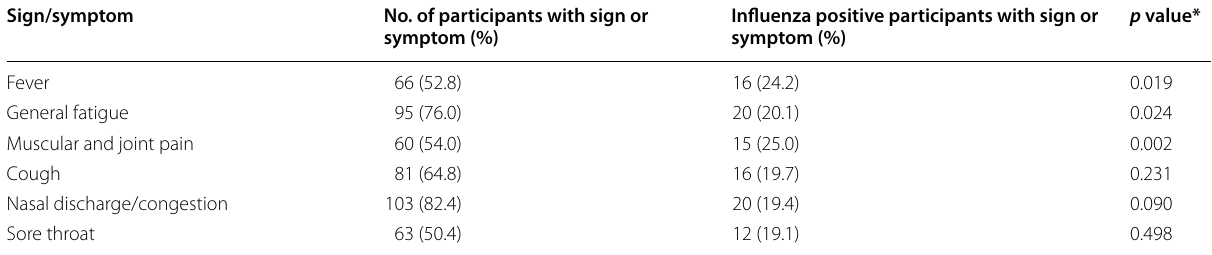
* p value of association between sign or symptom and detection of influenza virus